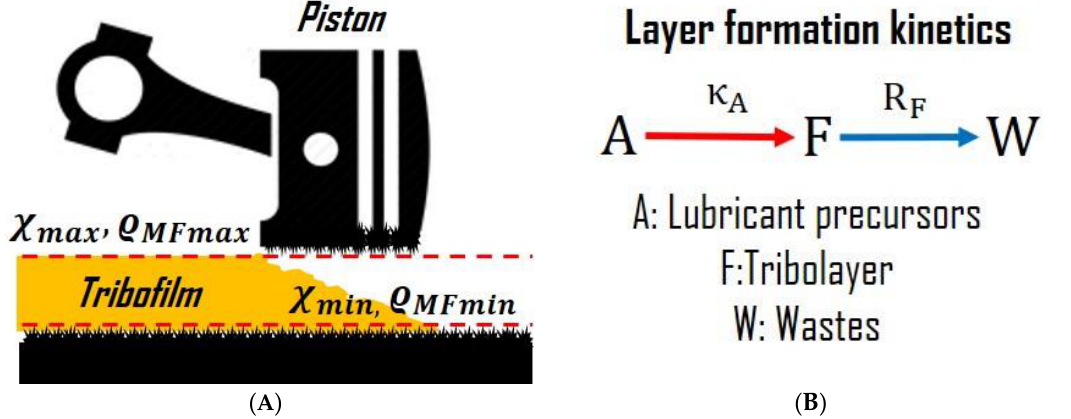
Figure 2. ( A ) Growth restrictions of the tribofilm and ( B ) Reactive scheme of tribofilm formation.